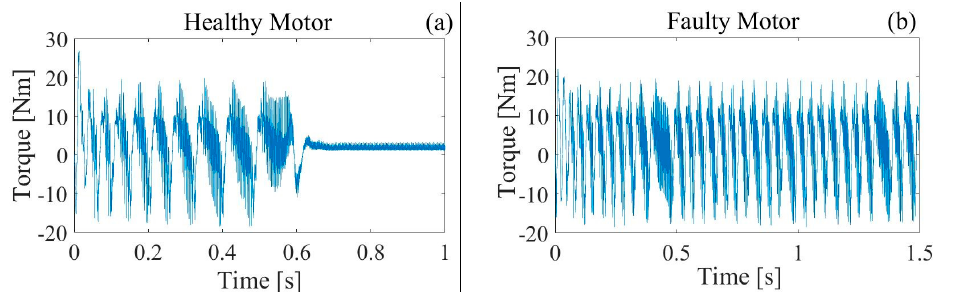
Figure 12. Comparison of the maximum starting torque [2.3 Nm] for ( a ) healthy and ( b ) faulty motor.